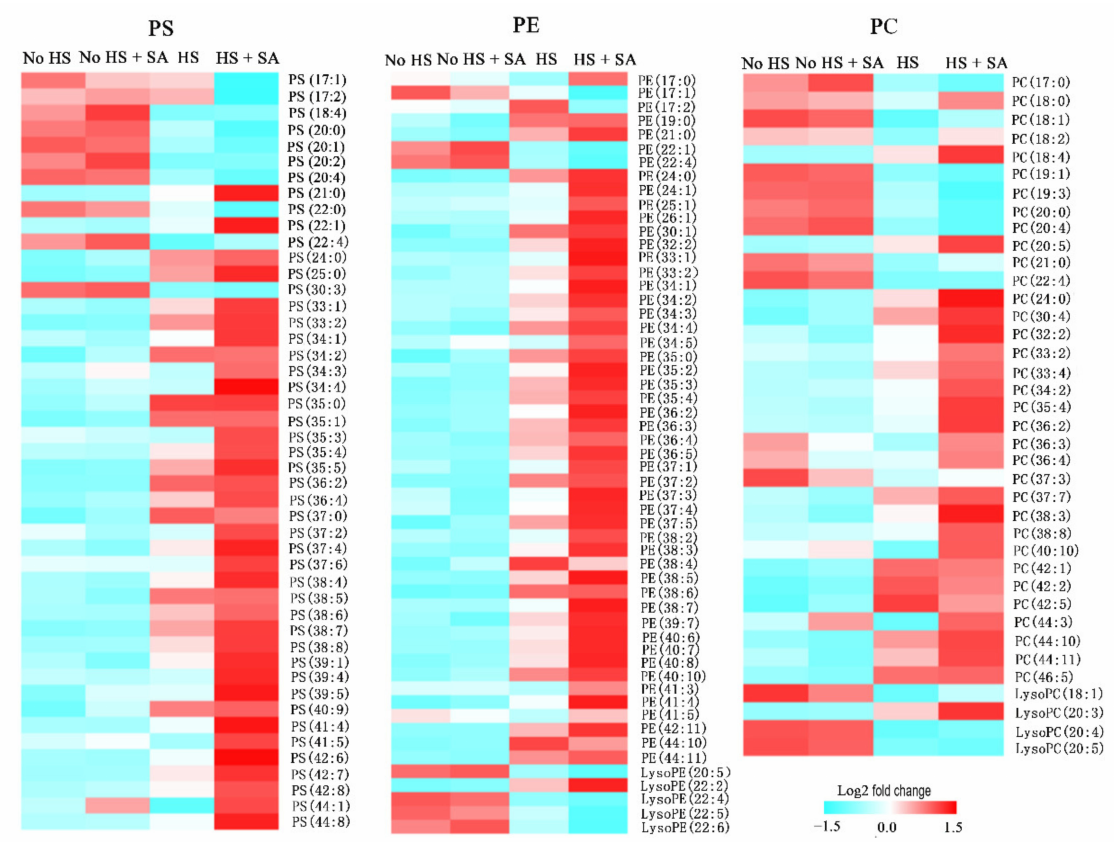
Figure 5. Phosphoglycerolipids composition analysis. PS: phosphatidylserine; PE: phos- phatidylethanolamine; PC: